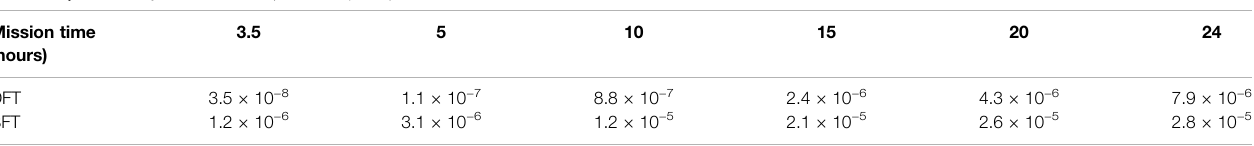
TABLE 3 | Unreliability of DGS in the period of (3 , 24) hours .